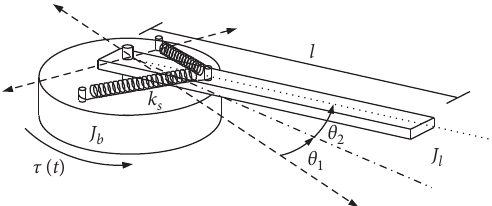
Figure 2: Schematics of the rotatory flexible